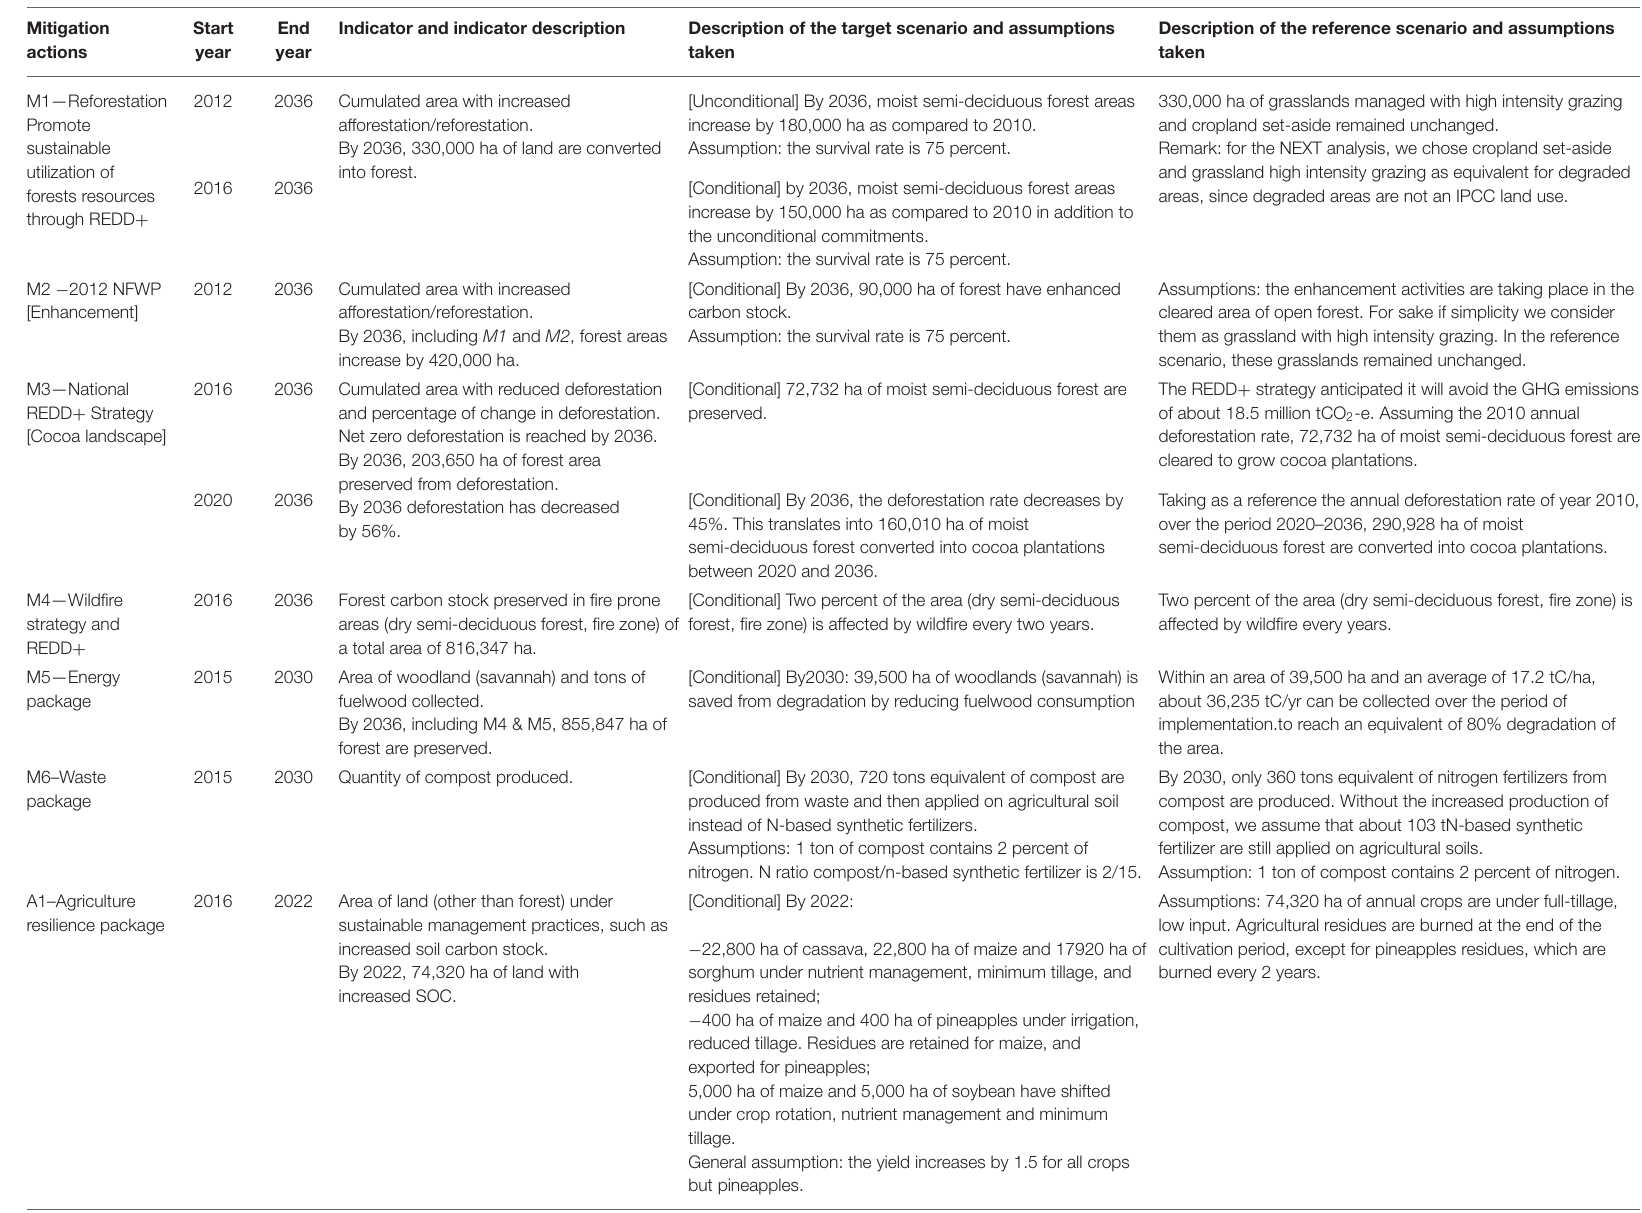
TABLE 6 | Indicators derived from the analyzed policy and measures, description and assumptions taken for the target and reference